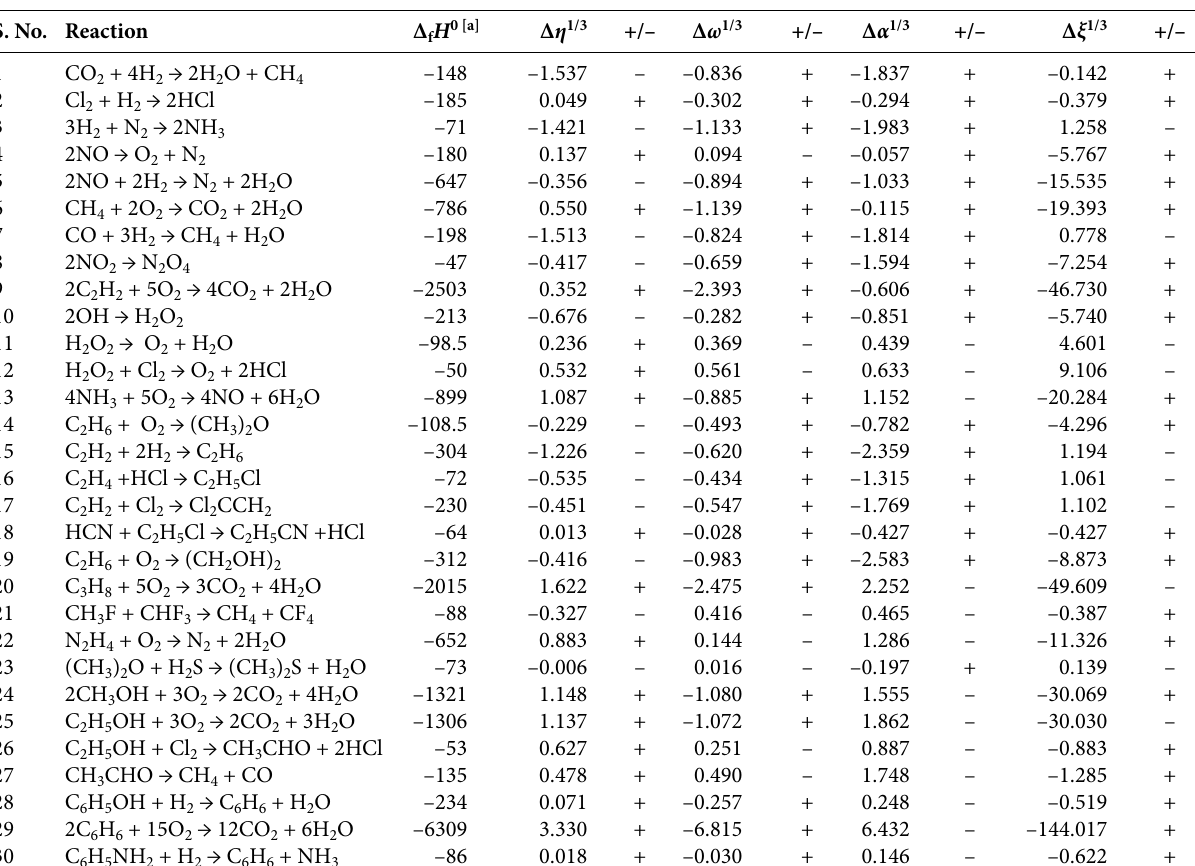
Table 3. Computed changes in the enthalpy (Δ f H 0 ) (at 298K in kJ mol –1 ), cube–root of hardness (Δ η 1/3 ) (in au), cube–root of electrophilicity index (Δ ω 1/3 ) (in au), cube–root of polarizability (Δ α 1/3 ) (in au) and cube–root of magnetizability (Δ ξ 1/3 ) (in au) along with MHP, MEP, MPP and MMP validity (+) or invalidity (–) for selected reactions S. No.